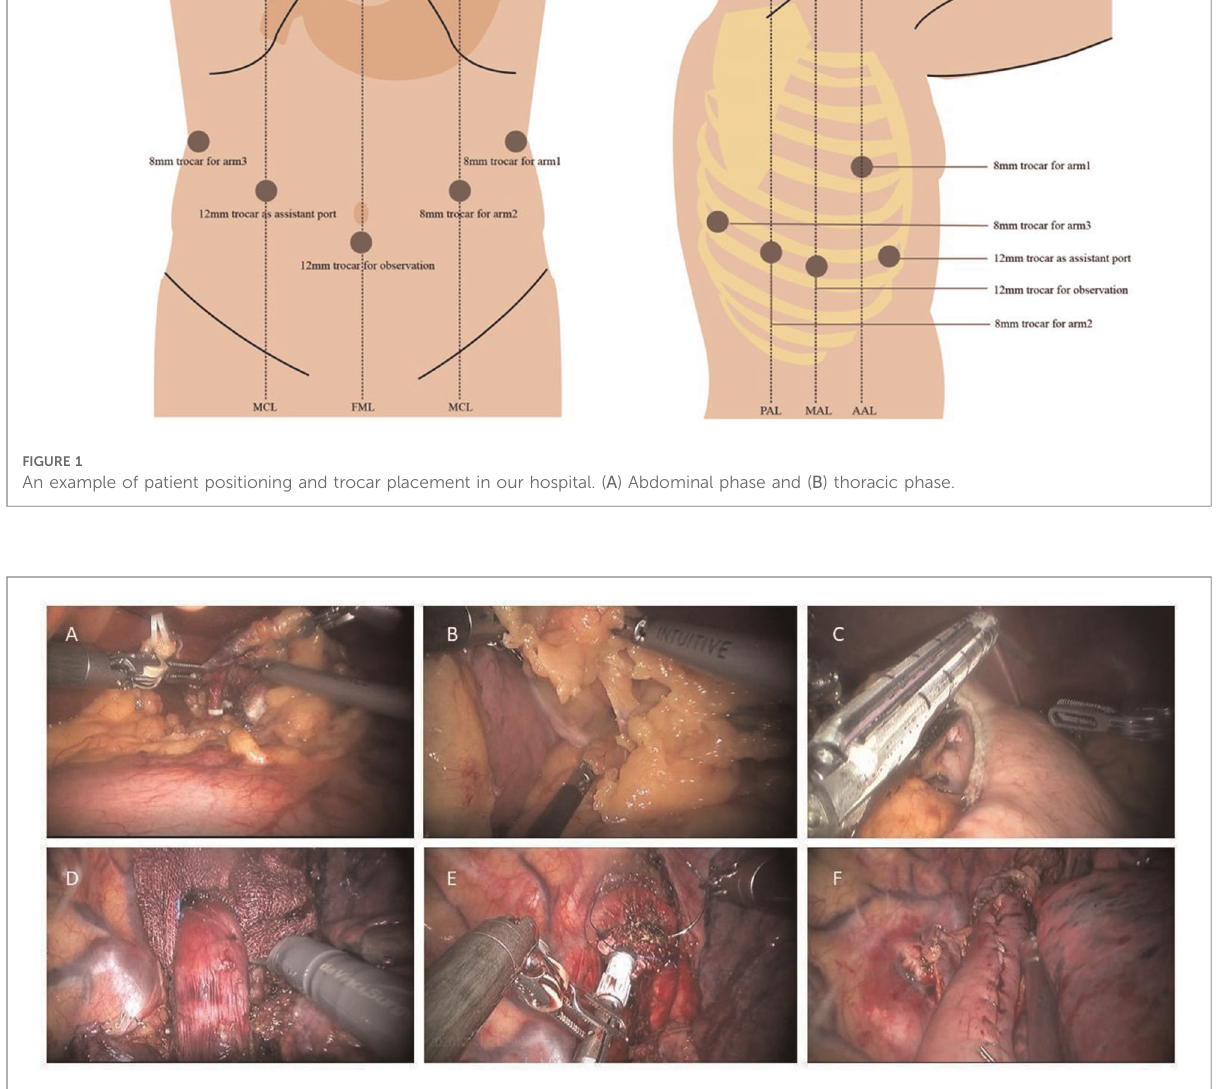
FIGURE 2 Key steps in robot-assisted Ivor Lewis esophagectomy. ( A ) After the lesser omentum was divided, the left gastric pedicle was exposed and divided with Hem-o-lock clips and a vessel sealer. ( B ) The gastrocolic ligament was divided toward the left gastroepiploic pedicle. ( C ) A 4 – 5 cm wide gastric conduit was formed toward the fundus with several fi res of an Endostapler. ( D ) The esophagus was mobilized en bloc down to the gastroesophageal junction with dissection of all surrounding lymph node tissues. ( E ) The anvil of a 25-mm Premium Plus CEEA circular stapler was carefully inserted into the distal esophageal stump and fi xated with two separate concentric purse-string sutures. ( F ) The form of a completed esophagogastric